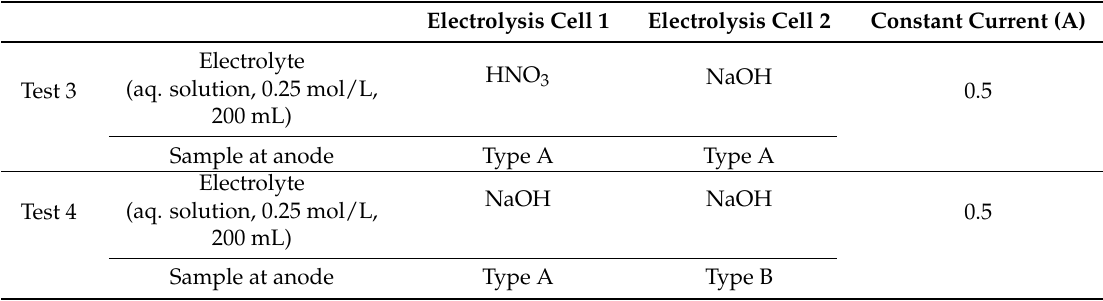
Table 2. Summary of the electrochemical delamination comparison experiments using O 2